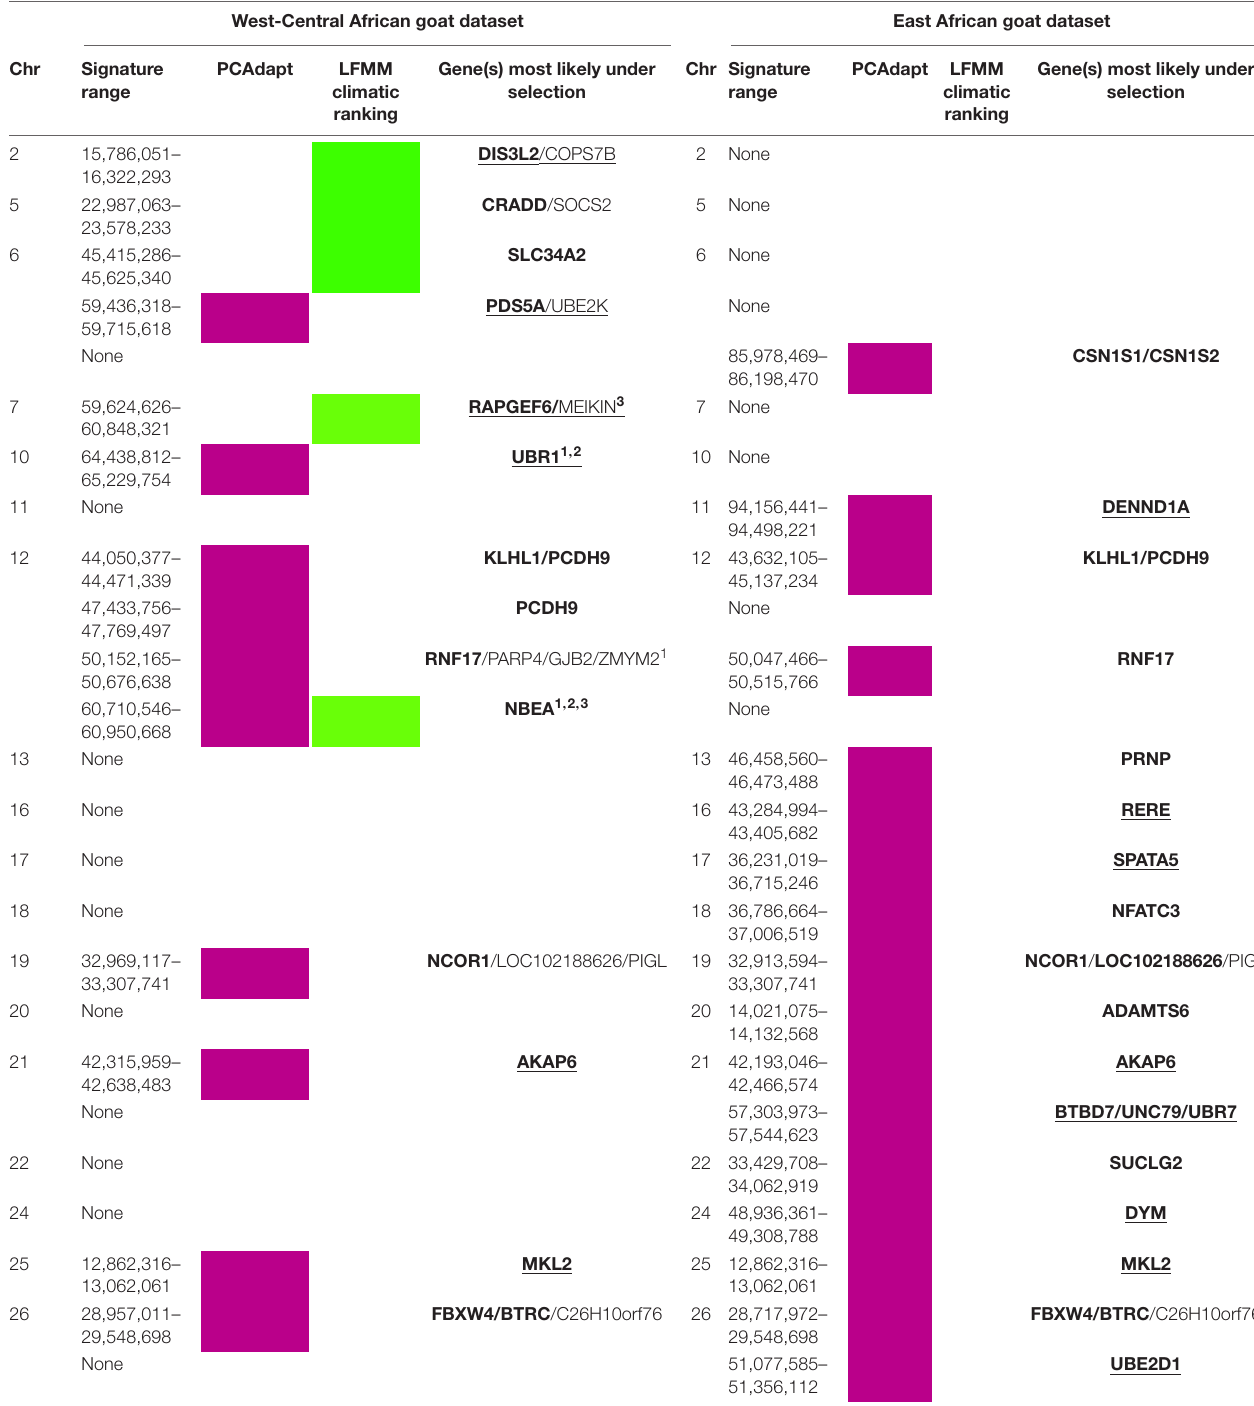
TABLE 3 | Selection signatures identified in the West-Central African goat and East-African goat by LFMM following the infestation ranking and